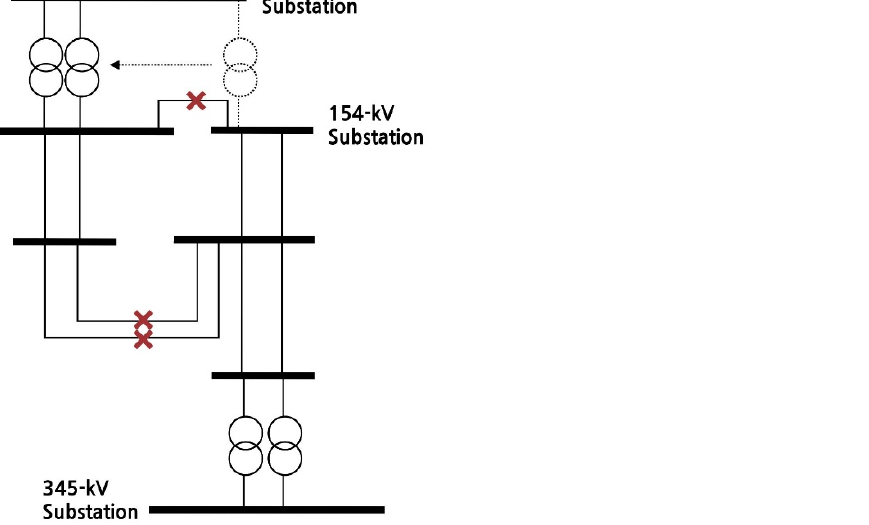
Figure 4. Line separation method with an insufficient transformer capacity.